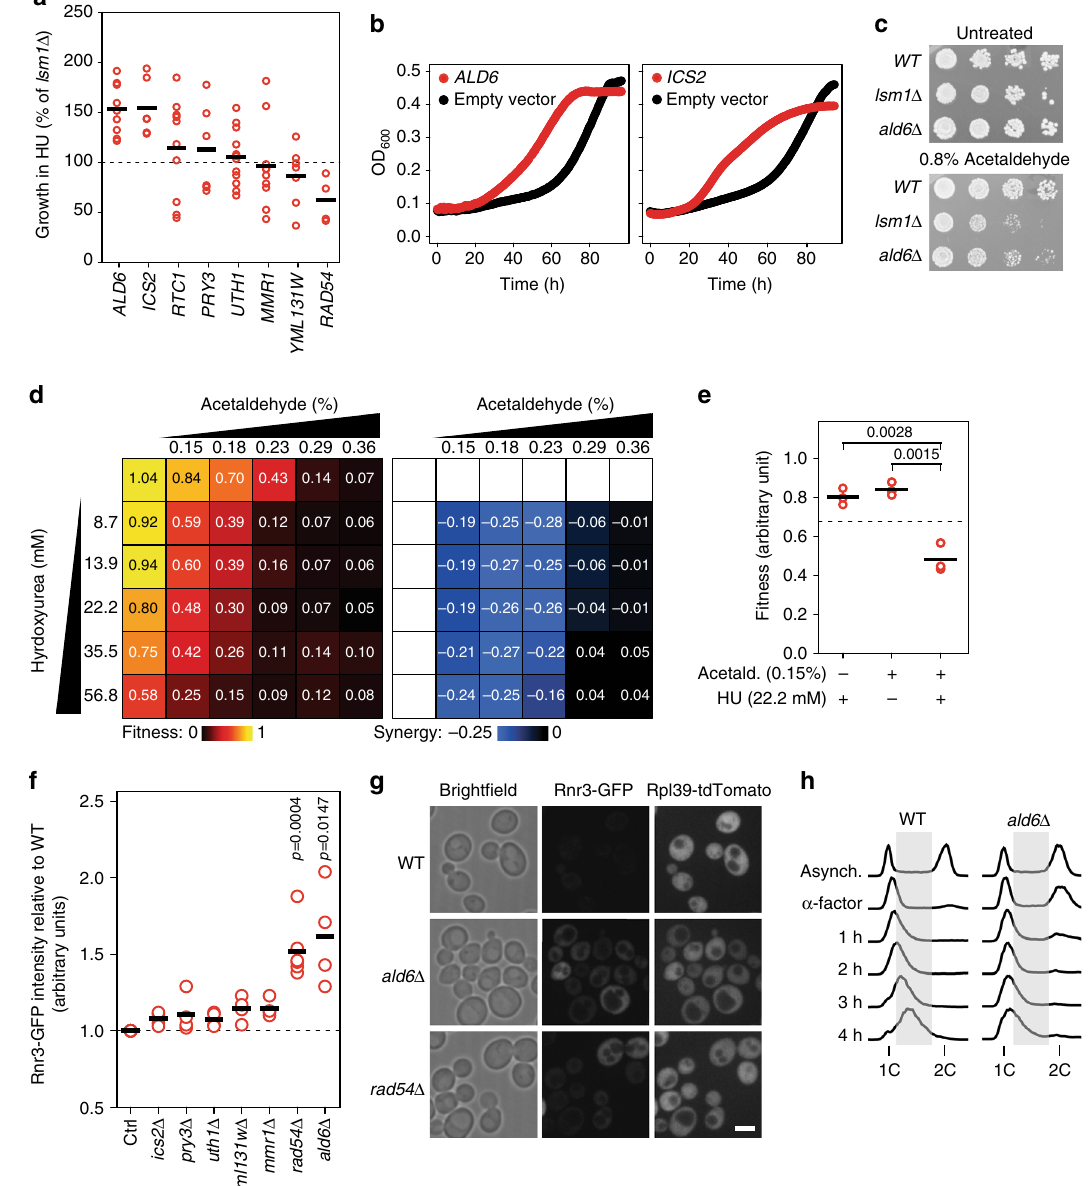
Fig. 7 De-repression of the Yox1 target ALD6 is critical to detoxify acetaldehyde and promote DNA replication stress resistance. a Relative growth of lsm1 Δ cells overexpressing the indicated genes compared to lsm1 Δ cells containing the control vector. Each data point represents a single replicate. Each experiment was repeated at least three times and included two independent biological replicates each time. The solid bar indicates the average. b Growth curves of lsm1 Δ cells overexpressing ALD6 or ICS2 ( red ) or lsm1 Δ cells containing the control vector ( black ) in the presence of HU. c Serial 10-fold dilutions of the indicated strains were spotted on YPD with or without acetaldehyde. Plates were imaged after 3 – 4 days of growth. d Left : Heatmap of fi tness values of cells grown in presence of acetaldehyde, hydroxyurea or combinations of both drugs. Fitness values are relative to the untreated condition, for three independent replicates. Right : Synergy heatmap. Indicated values correspond to the difference between the observed fi tness in the given drug combination and the expected fi tness. e Fitness of cells grown in presence of acetaldehyde, hydroxyurea or combination of both drugs at the indicated concentrations. Each data point represents one replicate. P -values are from a Student ’ s t -test. f Rnr3-GFP intensities in the indicated mutants relative to the WT. Each data point represents one replicate. P -values are from a Student ’ s t -test. g Representative microscopic images of the indicated strains expressing Rnr3-GFP and RPL39pr-TdTomato. Scale bar : 5 µ m. h Cell-cycle progression of the WT and ald6 Δ strain after alpha-factor block and release in YPD